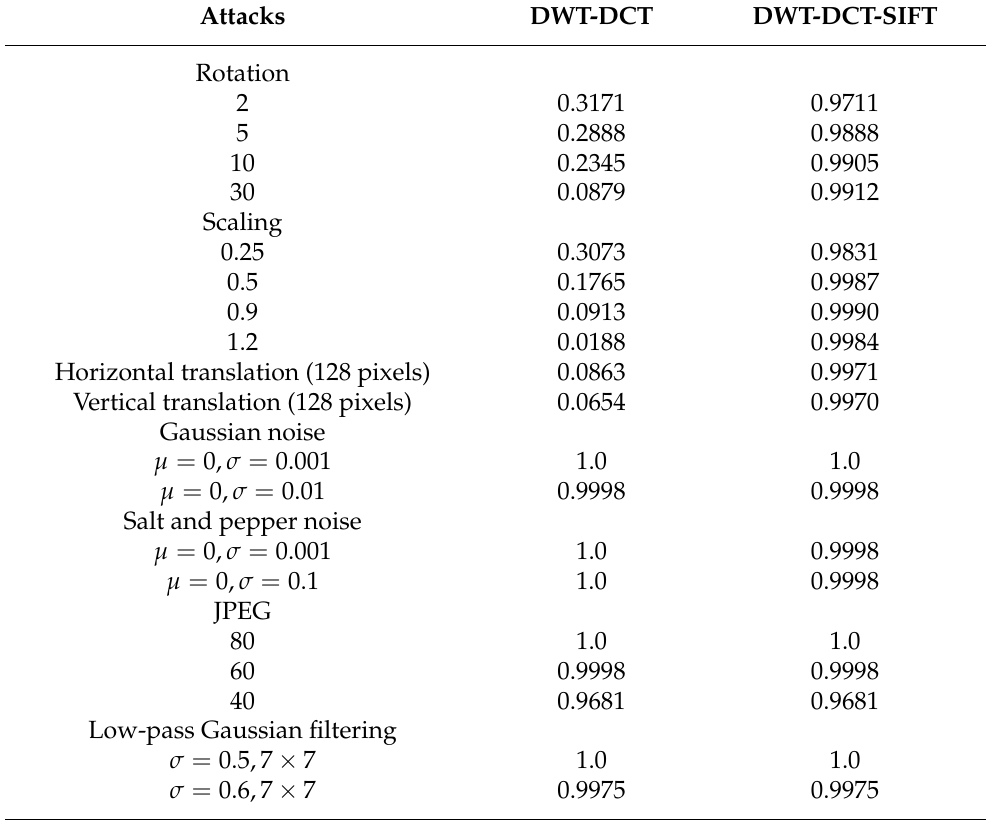
Table 12. Watermark robustness measured in terms of NC with and without SIFT for cameraman